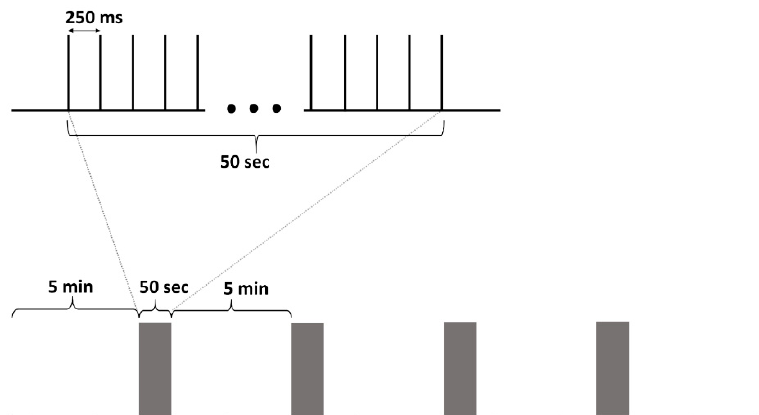
Figure 1. The stimulation protocol. A stimulation train consisted of 50 s, 4 Hz, continuous, regular interstimulus interval stimulation. The daily stimulation package consisted of 4 stimulation trains separated by 5 min pauses. 5-min pre- and post-stimulation period was recorded